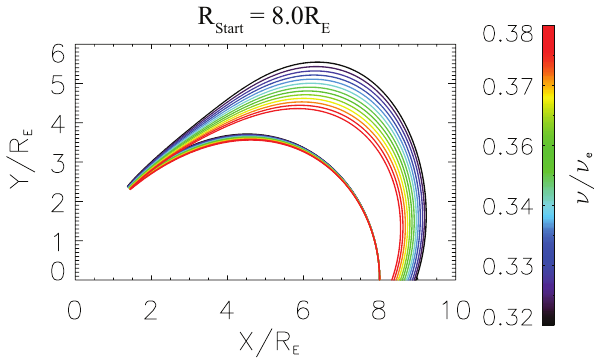
Fig. 6. All whistlers start parallel to the local magnetic field, at L = 8. After reflection the waves spread towards a range of higher